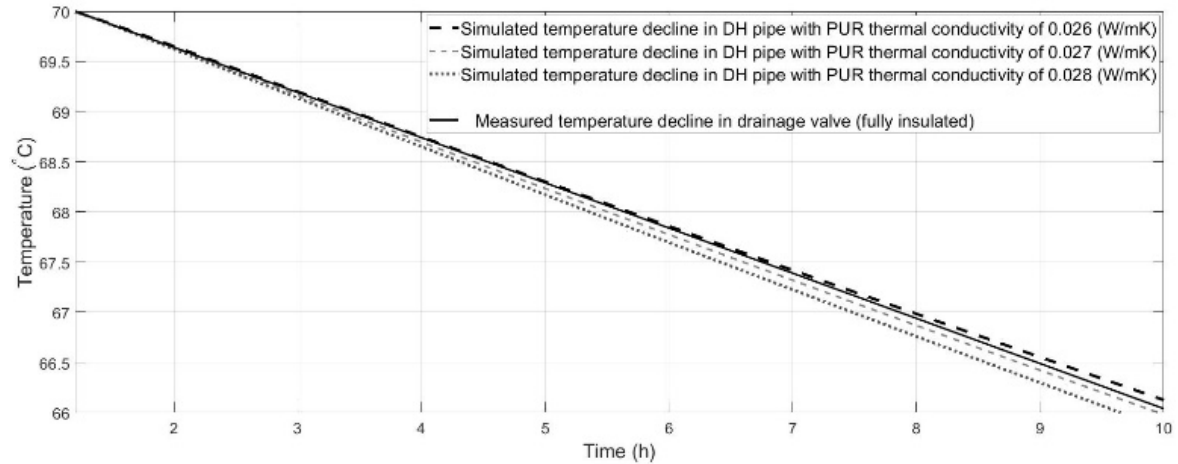
Figure 11. Measured average temperature decline in the drainage valve after the thermal response time during the three shutdowns versus simulated temperature decline in DH pipe with PUR thermal conductivity of 0.026–0.028